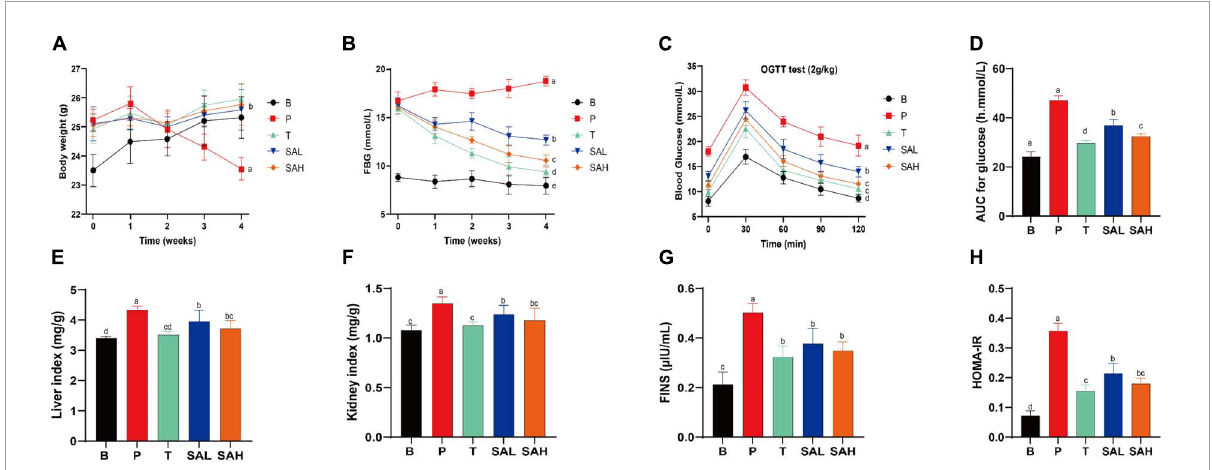
FIGURE1 Sciadonic acid (SA) improved body parameters in type 2 diabetes mellitus (T2DM) mice. (A) BW, (B) FBG, (C) OGTT, (D) AUC of OGTT, (E) liver index, (F) kidney index, (G) FINS, and (H) HOMA-IR. Data were presented as the mean ± SD ( n = 6). Different letters represent a significant difference among multiple groups ( P < 0.05). B, control group; P, diabetic model group; T, (HFD + 200 mg kg – 1 Met); SAL, (HFD + 70 mg kg – 1 SA); SAH, (HFD + 280 mg kg – 1